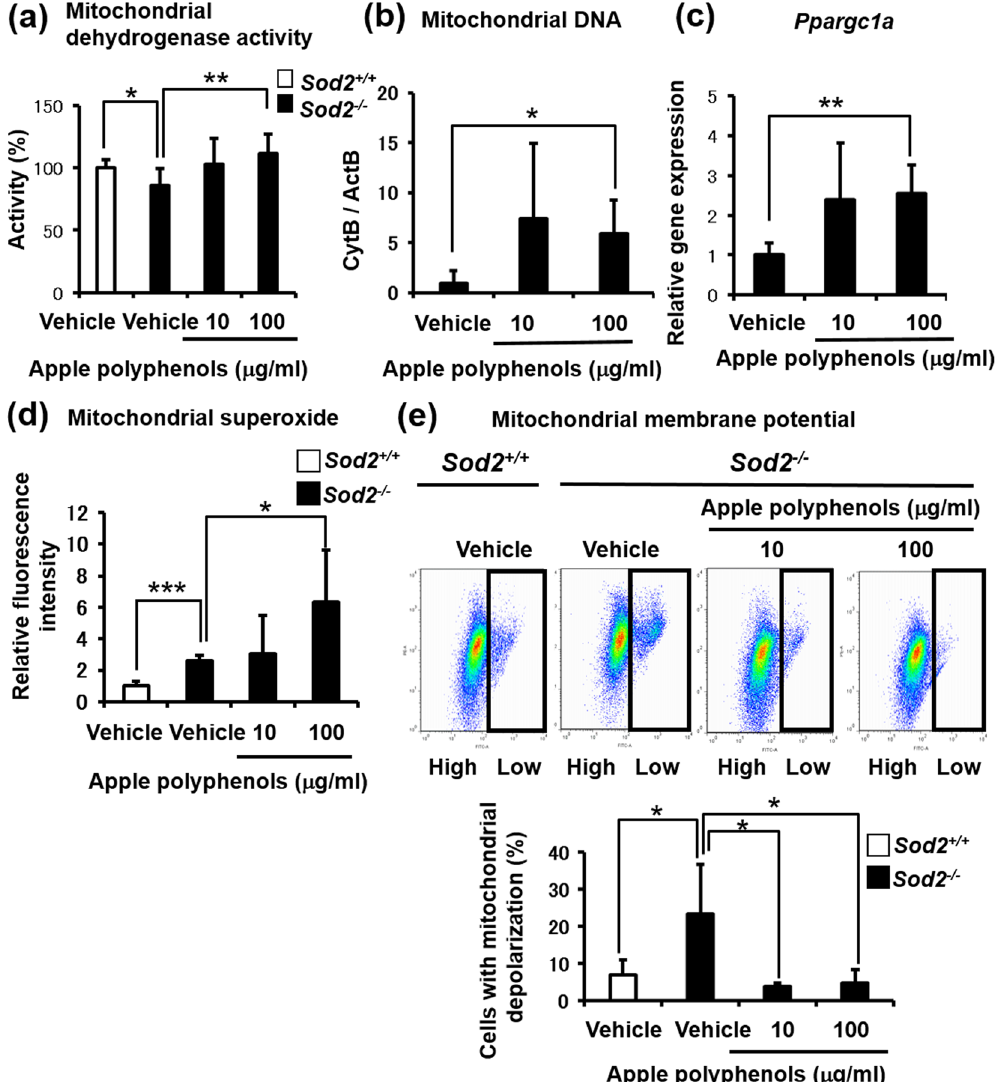
Figure 2. Apple polyphenols attenuate mitochondrial dysfunction through mitochondrial biogenesis in Sod2- deficient chondrocytes. Apple polyphenols were added to primary or Sod2- deficient murine chondrocytes for 24 h. ( a ) Mitochondrial dehydrogenase activity (n = 6–8), ( b ) mitochondrial DNA level (n = 3–5), ( c ) gene expression of PGC-1 α (n = 4), ( d ) mitochondrial superoxide (n = 5–6), ( e ) mitochondrial membrane potential ( ΔΨ m) (n = 3–5). Values are the mean ± standard deviation ( * P < 0.05, ** P < 0.01, *** P < 0.001 versus control, Student’s t